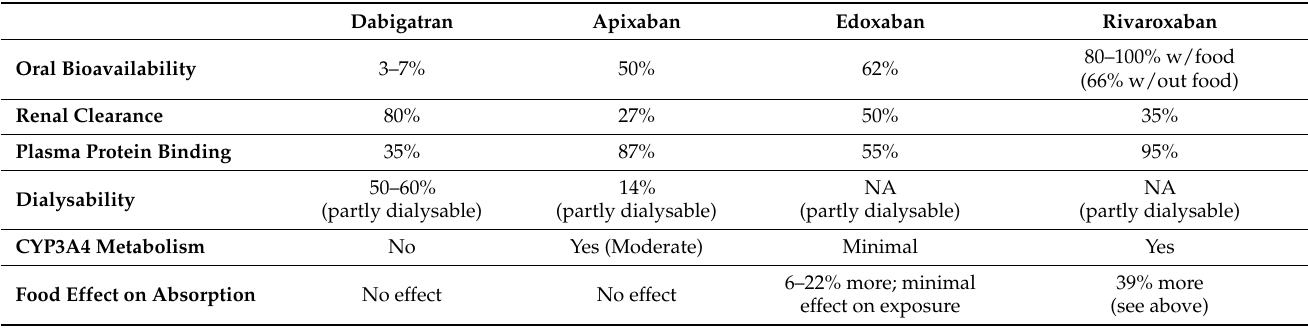
Table 1. Comparison between DOACs main characteristics (Based on